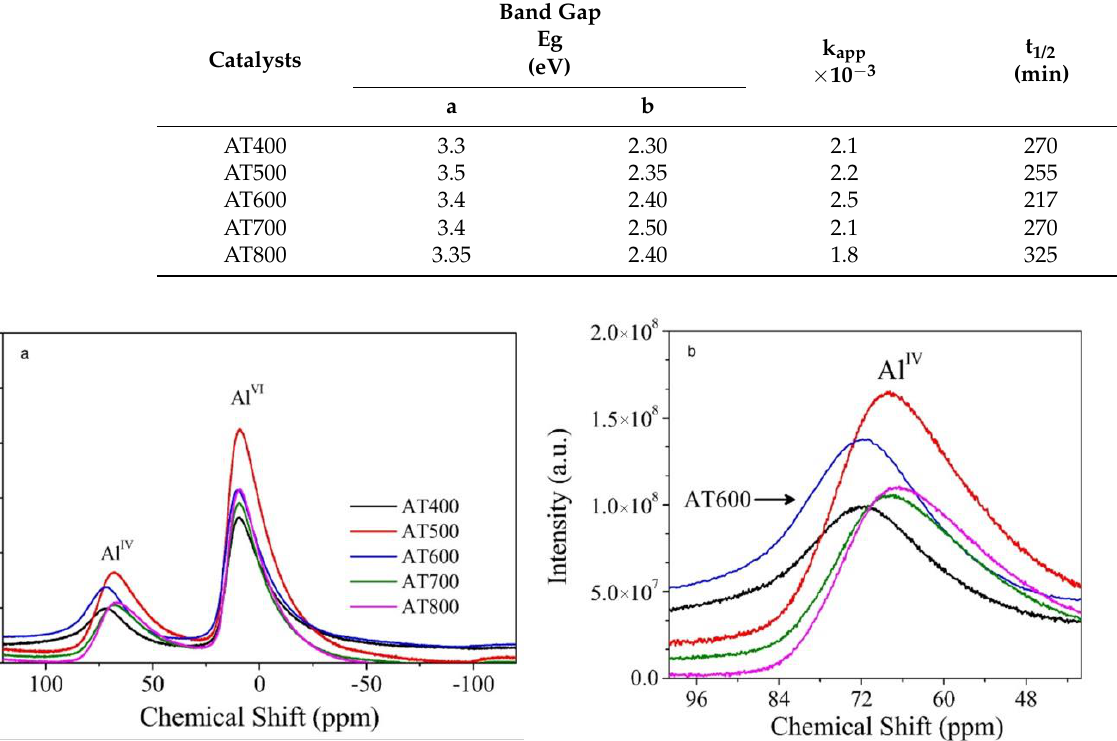
Figure 4. ( a ). 27 Al MAS-NMR spectra for the AT calcined at different temperatures, ( b ). attenuation of Al IV . 6.0 × 10